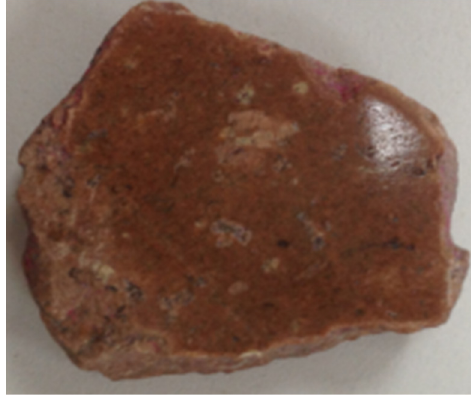
Figure 8. Appearance of the polished aggregate.